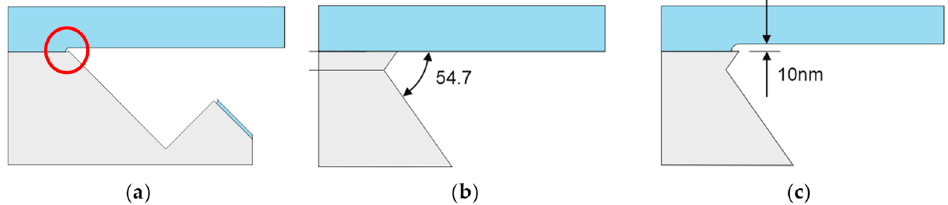
Figure 18. ( a ) Undercutting of the SiO 2 mask (indicated by red circle) after removing the G1 masking layer. ( b ) Formation of extra corner in Si by using TMAH. ( c ) The combined result of both effects.